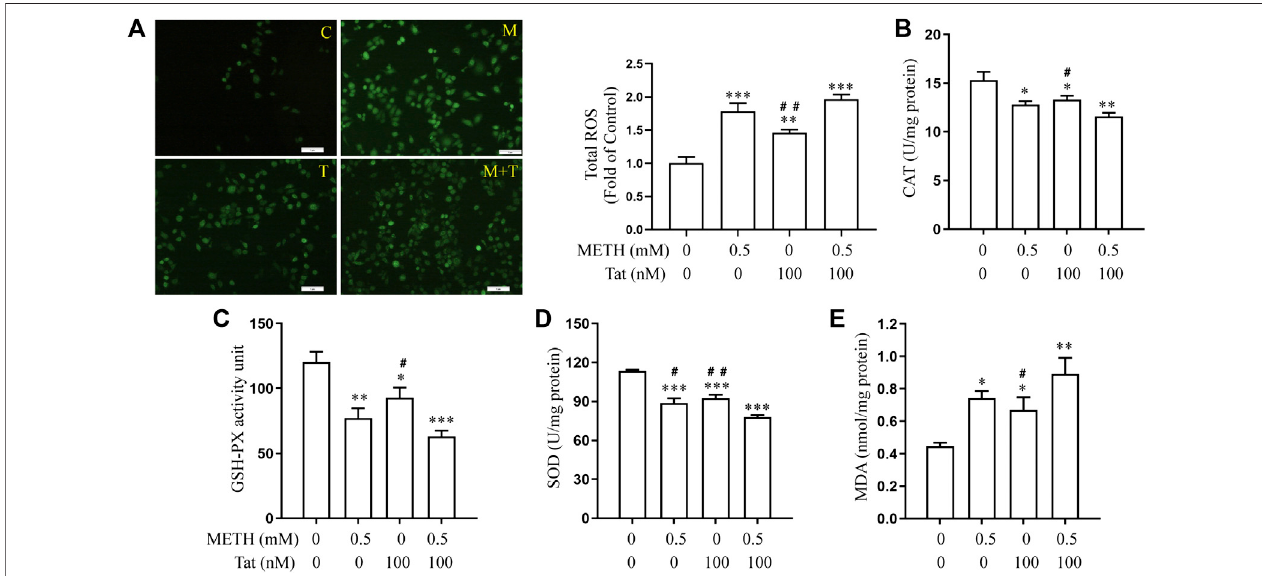
FIGURE 2 | METH and HIV-Tat synergistically induce oxidative stress responses. After the hCMEC/D3 cells were treated with 0.5 mM of METH and/or 100 nM of HIV-Tat for 24 h, (A) the ROS fl uorescence was observed by an inverted fl uorescence microscope (Scale bar: 1 µm), and the fl uorescence intensity was analyzed by ImageJ software; (B – E) the activity ofCAT, GSH-PX, and SOD and thelevel of MDA were measured using commercial kits. Compared with thecontrol, * p < 0.05, ** p < 0.01,*** p < 0.001;comparedwiththeMETH+HIV-Tat, # p < 0.05, ## p < 0.01,n (cid:1) 3.C (cid:1) Control,M (cid:1) 0.5 mMofMETH,T (cid:1) 100 nMofHIV-Tat,andM+T (cid:1) 0.5 mM of METH+100 nM of